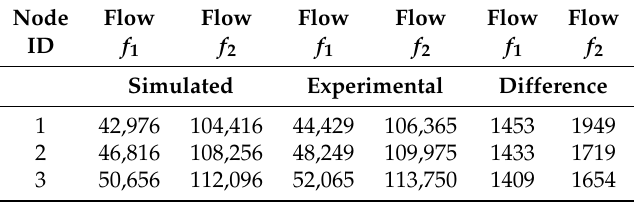
Table 4. Comparative end-to-end delays ( µ